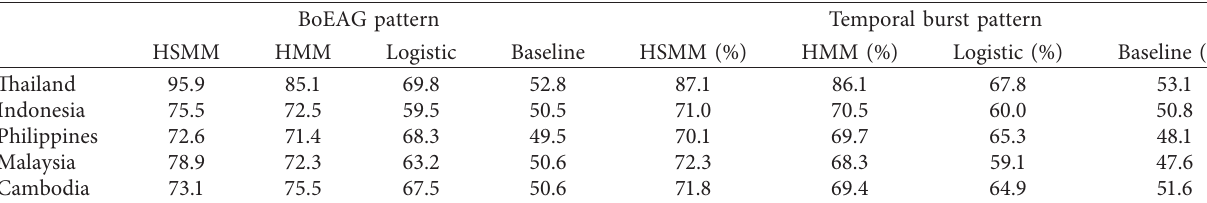
Table 3: The BACC value of each